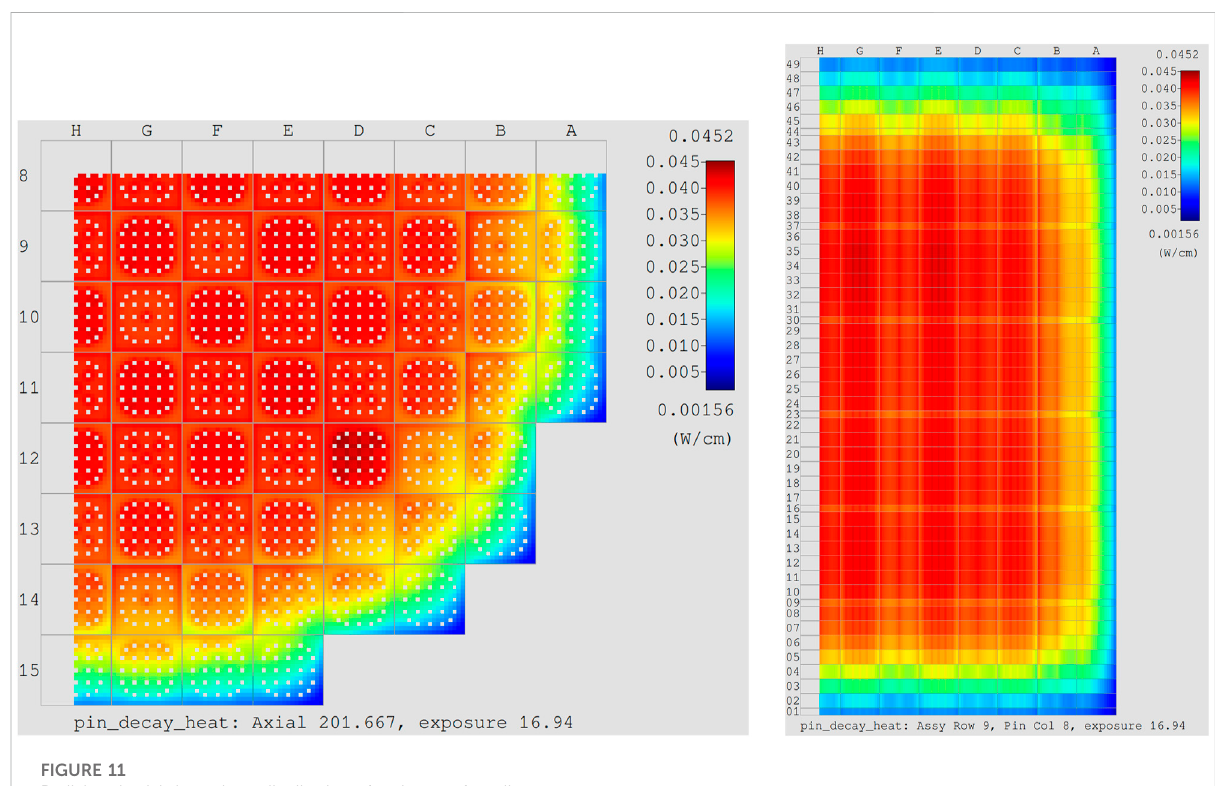
Radial and axial decay heat distribution after 1 year of